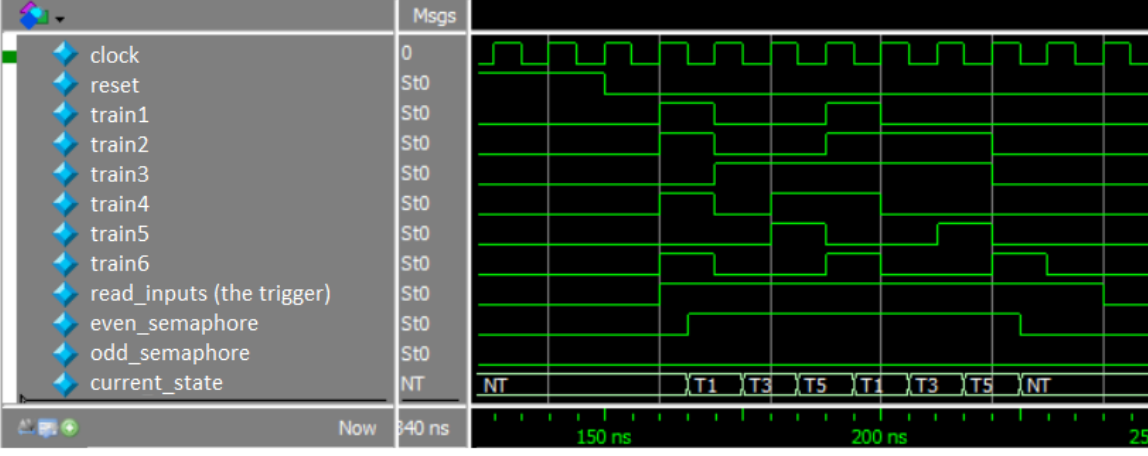
Figure 11. Screenshot from the Modelsim simulation of the digital railway management design. Each group of input stimuli used in the data sequences incorporates six bits, one for each train. A value of one means that the train in question is requesting to enter the